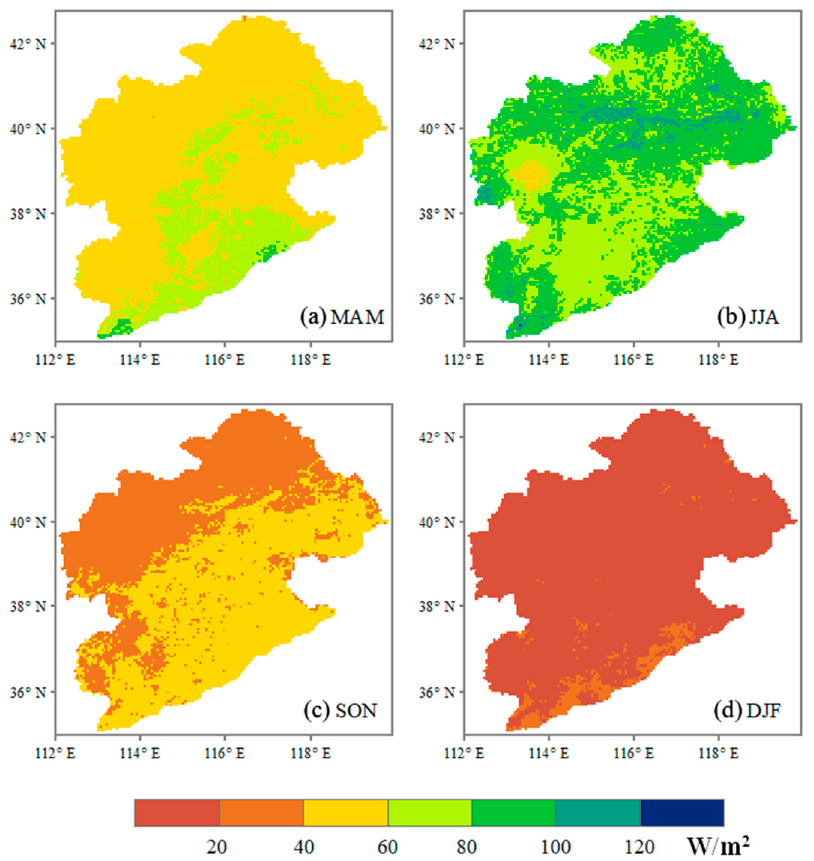
Figure 10. Maps of mean seasonality terrestrial LE from 2016 to 2018 using GBRT algorithms over HRB with a resolution of 0.05°. ( a ): spring; ( b ): summer; ( c ): fall; ( d ): winter.